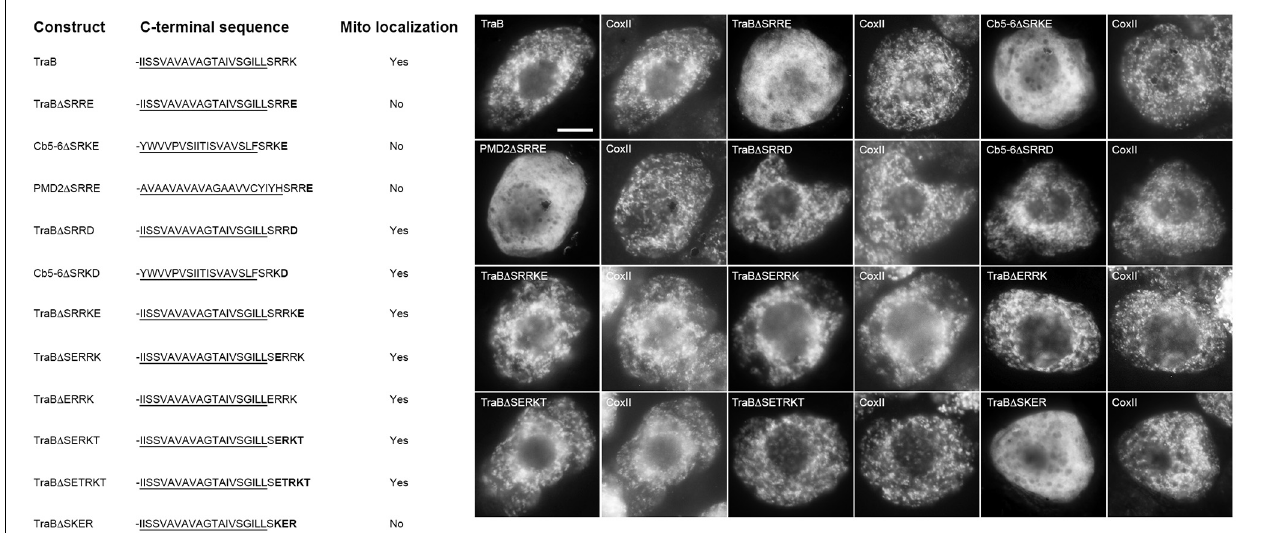
FIGURE 7 | Localization of various CTS mutant versions of mitochondrial-TA proteins in BY-2 cells. Shown on the left are schematic illustrations of wild-type and/or various CTS mutant versions of TraB, Cb5-6, or PMD2 and their corresponding localization (or lack thereof) to mitochondria in transformed BY-2 cells. The names of the mutants represent the specific amino acids in their modified CTSs. All constructs also possess an N-terminal-appended Myc-epitope tag. Shown for each construct is the corresponding C-terminal amino acid sequence, including putative TMD (underlined) and modified (or wild-type) CTS from